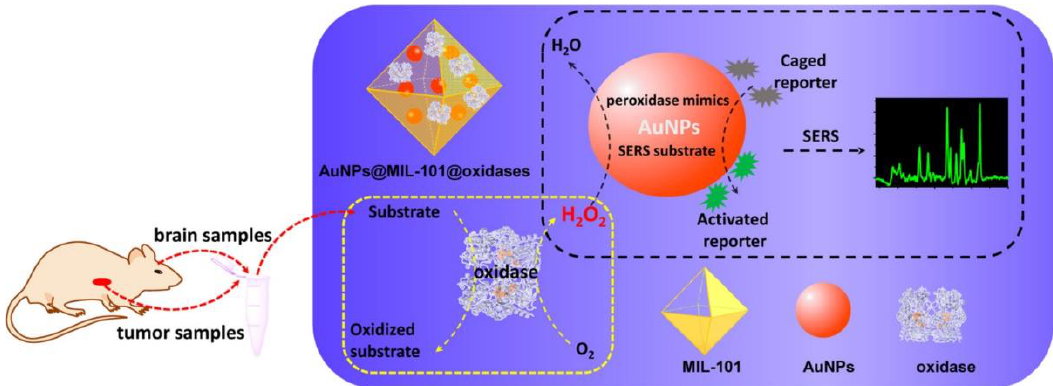
Figure 6. Schematic illustration of AuNPs@MIL-101@oxidases for efficient enzymatic cascade reac- tions. Reprinted with permission from [74] . Copyright 2017 American Chemical Society. tions. Reprinted with permission from [74]. Copyright 2017 American Chemical